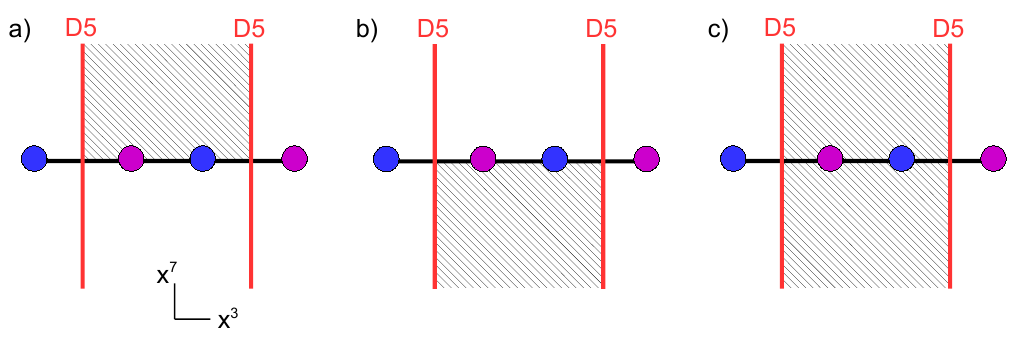
Figure 19 . Brane setups inserting: (a) Z + , (b) (cid:0) Z (cid:0) . From the setup (c) we read (cid:0) Z + Z (cid:0) = (cid:0) Z 1 X 1 X 2 Z 2 = ( X III ) 4